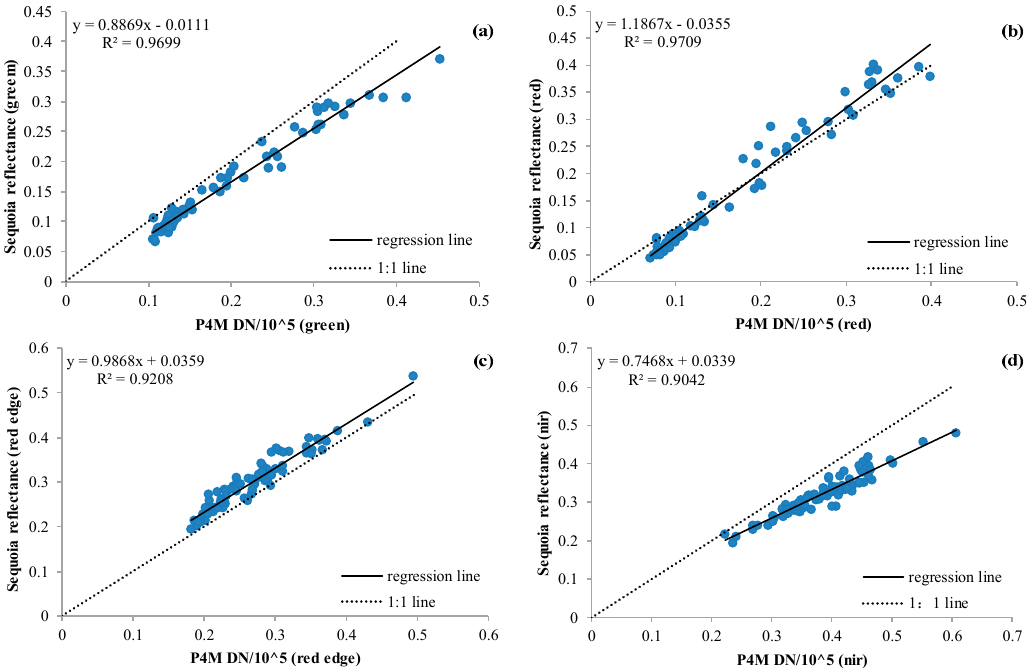
Figure 7. Scatter plots of Sequoia and P4M spectral values (5 cm) in the green band ( a ), red band ( b ), red edge band ( c ) and near infrared band ( d ). The solid lines show OLS regression of the Sequoia and the P4M data, and the dotted lines are 1:1 lines for reference.